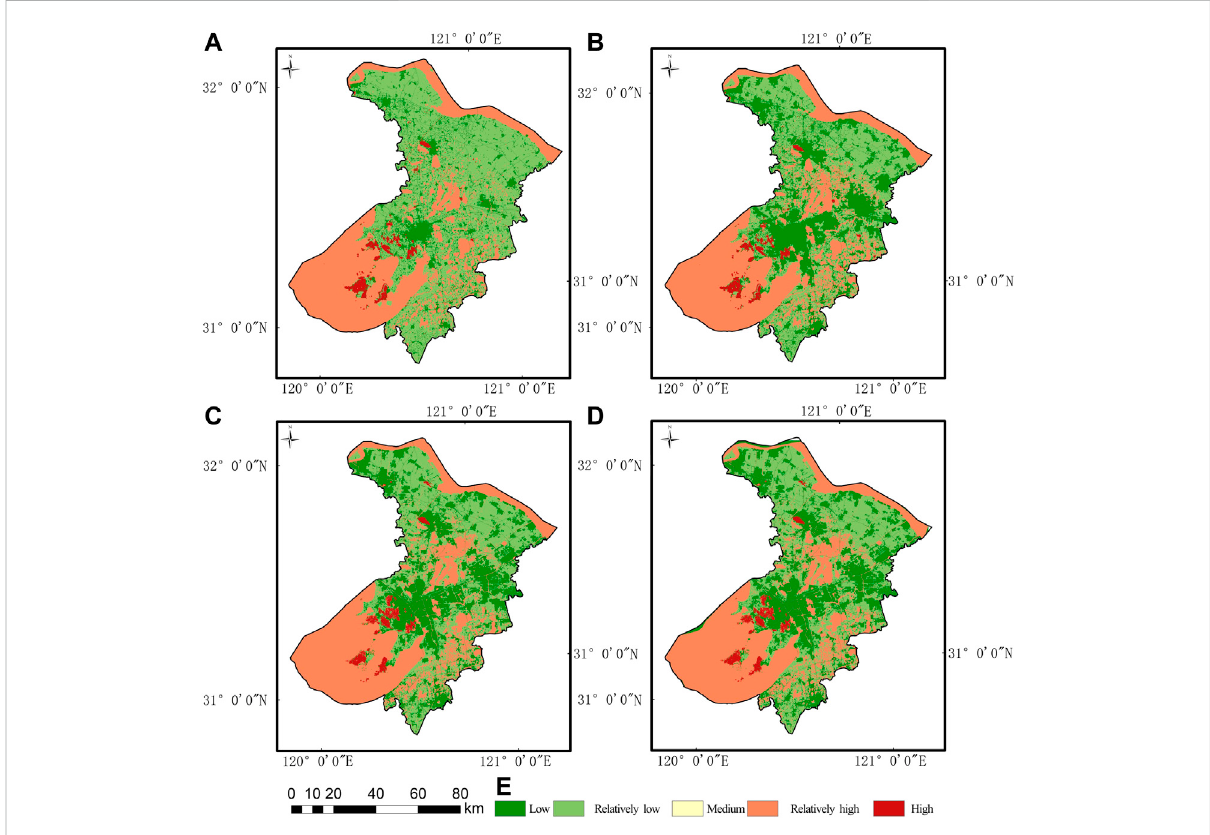
FIGURE 4 Habitat quality and its spatial distribution in Suzhou in different periods (A) 2000, (B) 2010, (C) 2020 and (D) spatial distribution simulation of habitat quality in